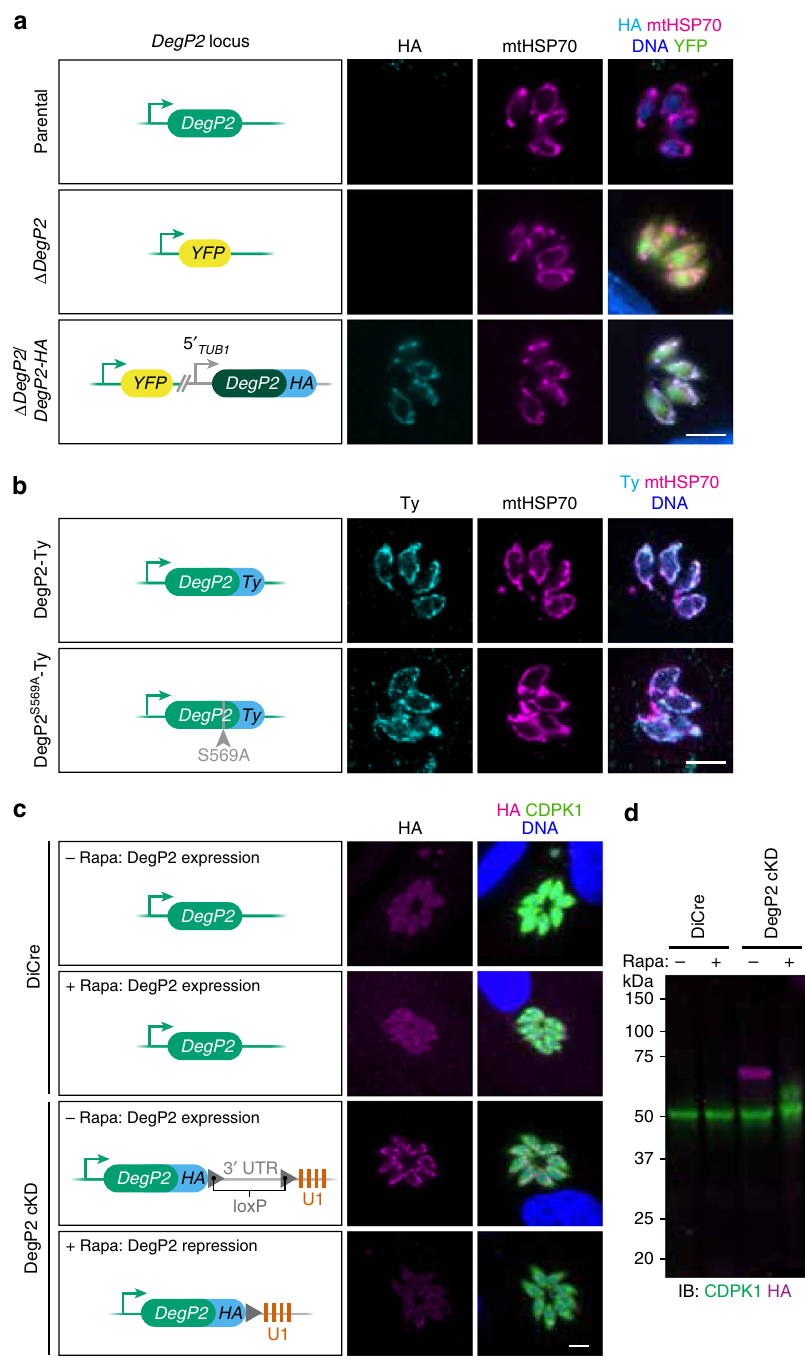
Fig. 4 Strains generated to study the function and localization of DegP2. a , b The DegP2 coding sequence was replaced with YFP to generate the Δ DegP2 line, which was subsequently complemented with an HA-tagged copy of DegP2 (dark green) under the regulation of the TUB1 promoter ( a ). Separately, the endogenous locus of DegP2 was fi rst tagged with the Ty epitope, and a point mutation was introduced at the catalytic serine ( b ). DegP2-HA, DegP2-Ty, and DegP2 S569A -Ty co-localized with the mitochondrial marker mtHSP70. Merged image additionally displays YFP (green) for Δ DegP2 strains and DNA stain (blue) for the HA-stained samples. Scale bar is 5 μ m. c A DegP2-inducible mutant constructed using the U1 system. Staining for the HA tag appended to the DegP2 cKD locus showed the expected localization of the protein to the mitochondrion. Individual parasites are visualized by staining for CDPK1. Scale bar is 5 μ m. d Immunoblotting for DegP2 ’ s HA tag showed robust depletion of DegP2 48 h after a 2 h rapamycin treatment. CDPK1 was used as a loading